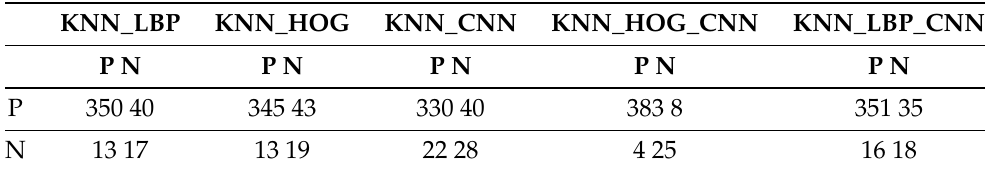
Table 7. Confusion Matrix for KNN with other Feature Descriptors.